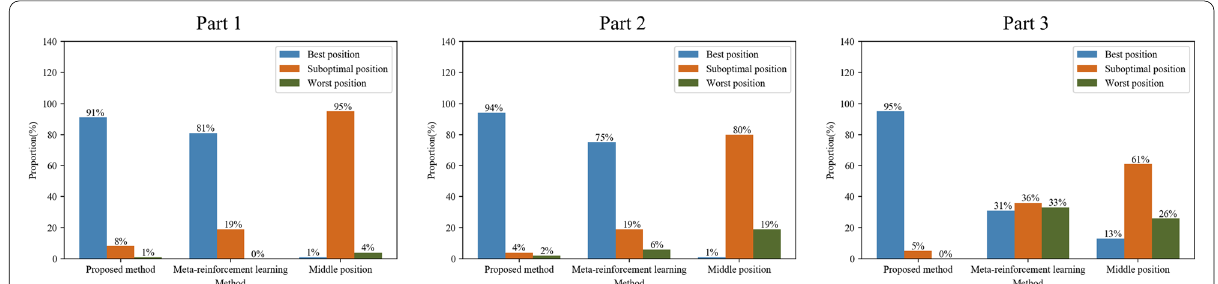
Fig. 12 Deformation control effects of three methods on three test